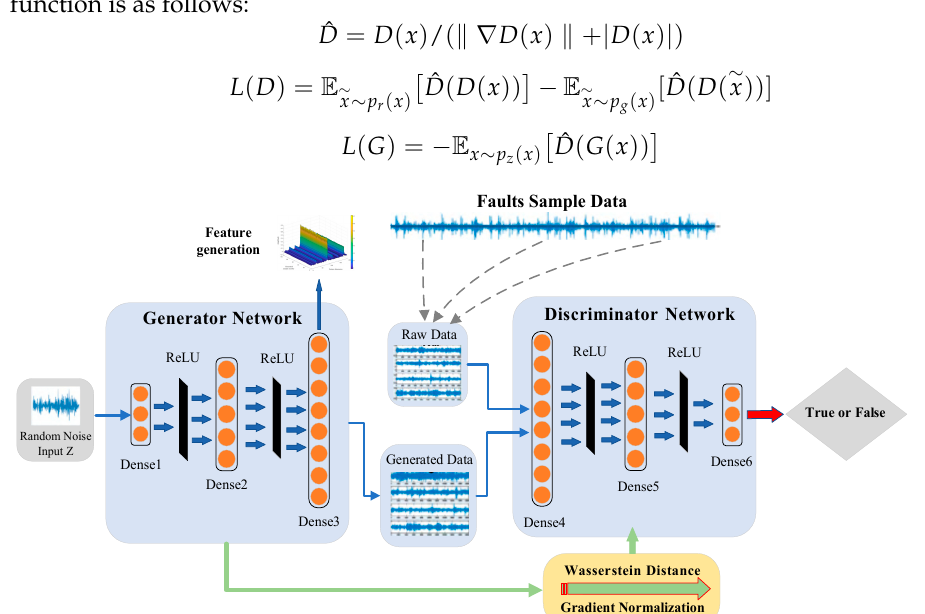
Figure 5. Structure of